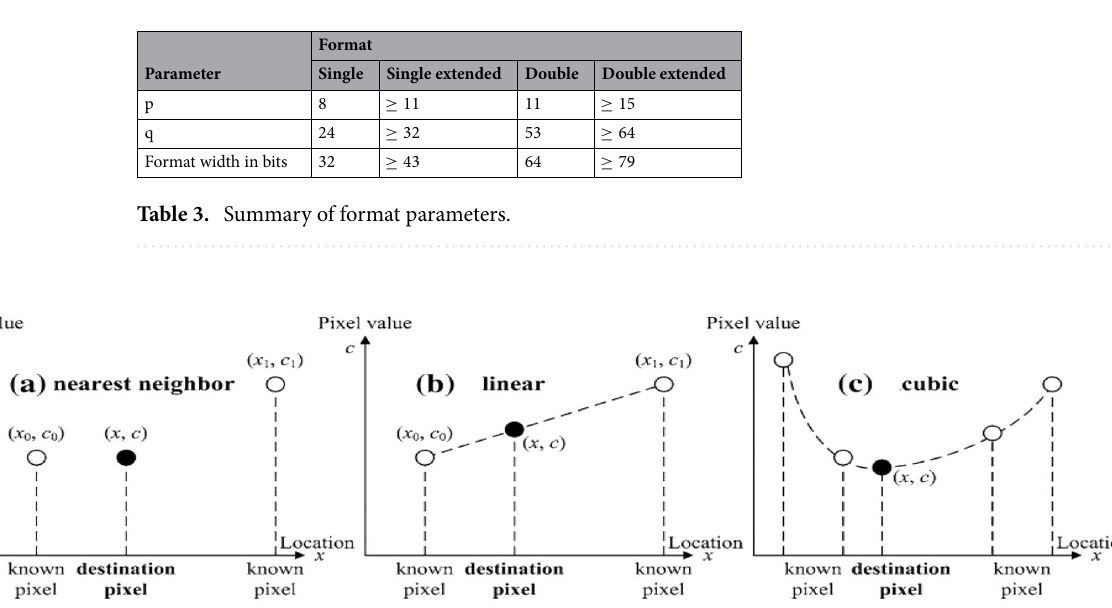
Figure 2. The principle of interpolation in one direction.